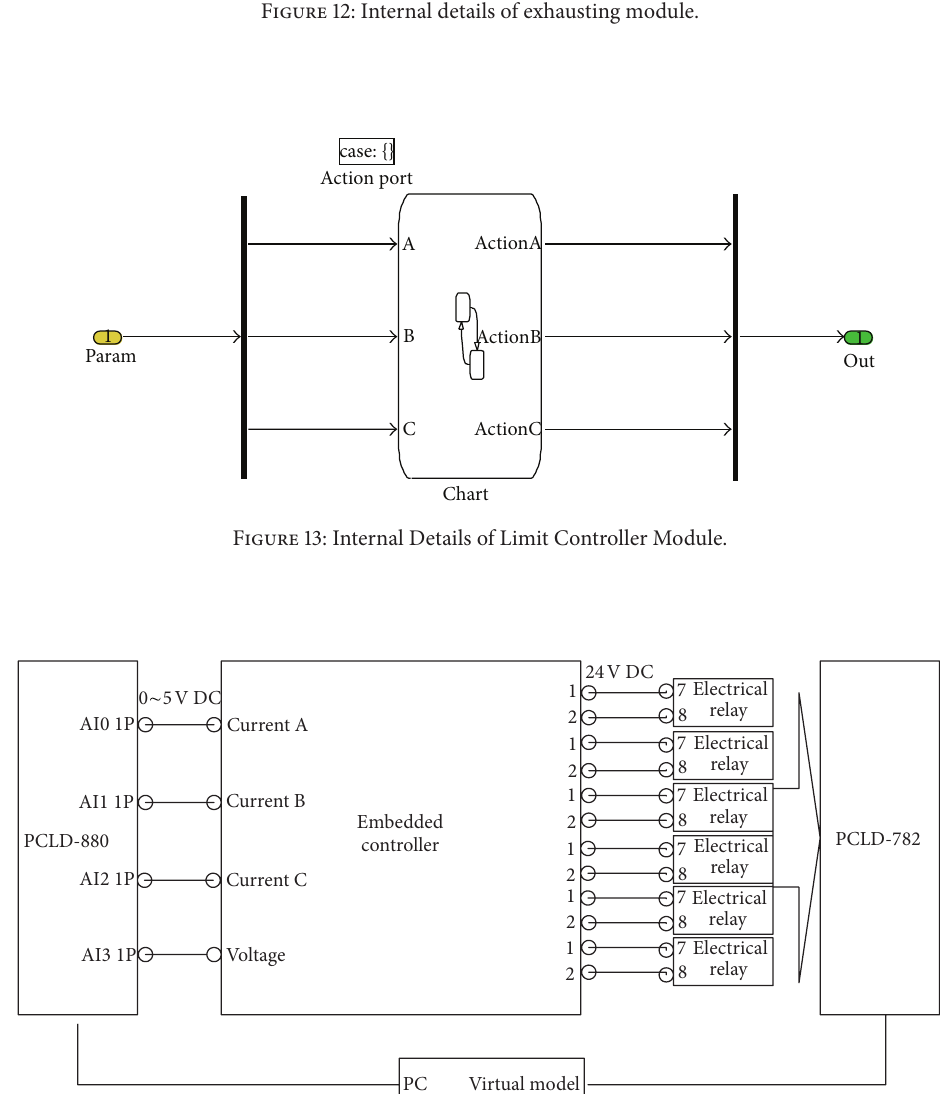
Figure 12: Internal details of exhausting module.